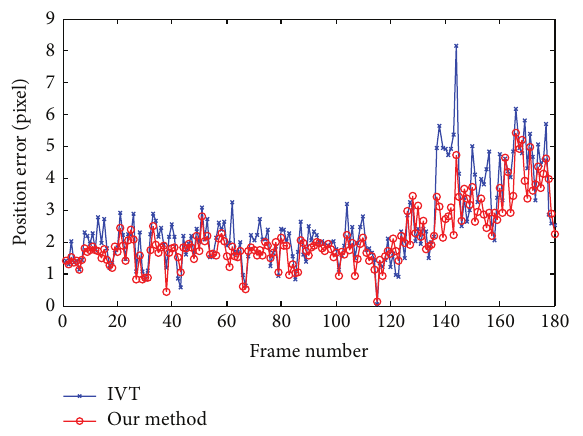
Figure 8: RSF for each cue throughout